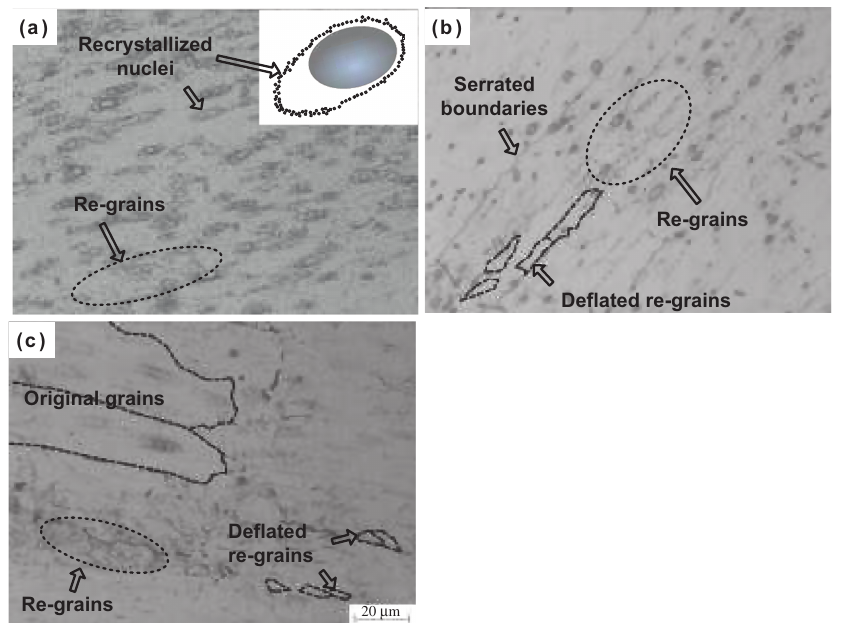
Figure 12: Microstructures of the specimens at the strain rate of 1 s − 1 and the temperatures of (a) 950°C, (b) 1,010°C and (c) 1,050°C, revealing the different recrystallization nucleation mechanisms during the fast hot deformation.